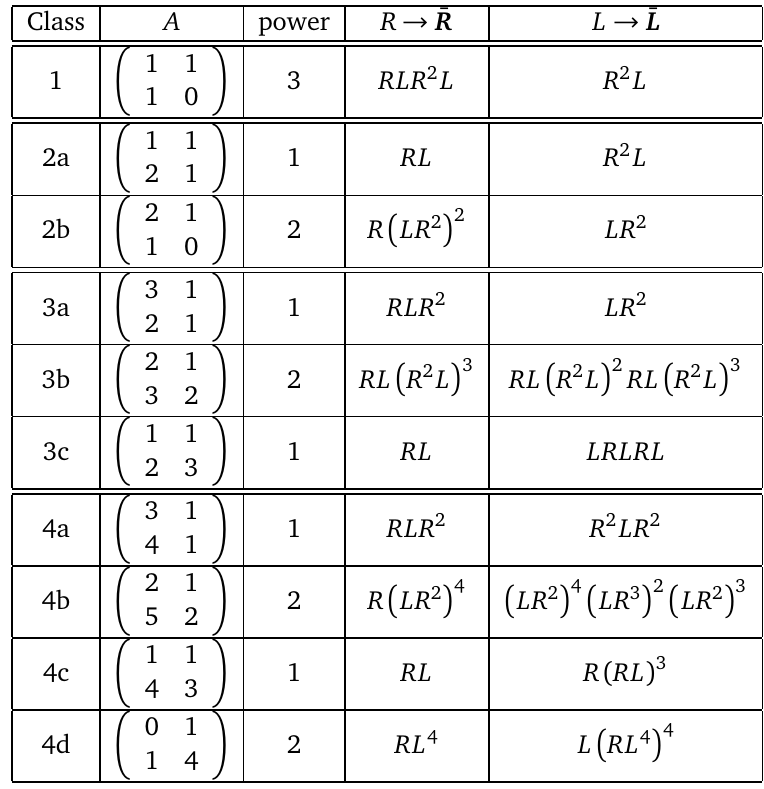
Table 2: The Boyle-Steinhardt classification of the ten physically-relevant quasilat- tices [ 2 ] . The first column lists the class, and the second column lists the growth matrix for the simplest substitution in that class, the largest eigenvalue of which is the PV number listed in Table 1 (consistent across the class). We consider the ad- missibility of these quasilattice inflation rules as cascades of words describing stable orbits in the logistic map universality class. The third column states the minimum number of compound inflations to describe an admissible substitution (the corre- sponding growth matrix will be the matrix in column two, raised to this power). The final columns list the inflations themselves. An infinite number of inflations applied to the word R results in a (generalised) time